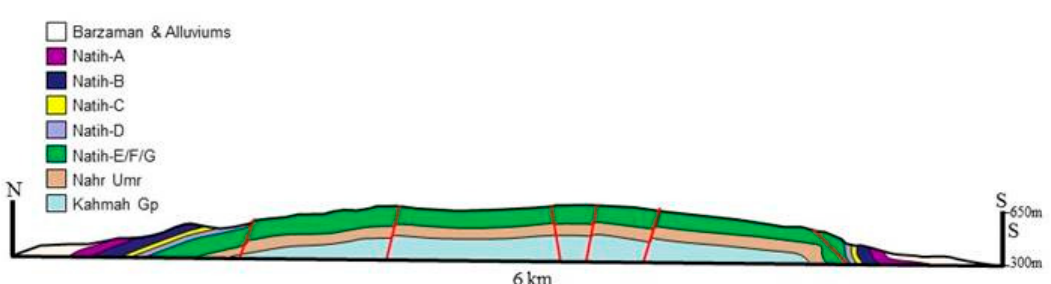
Figure 10. Surface cross sections through Jebel Madmar. The locations of the cross sections are shown in Figure 6.